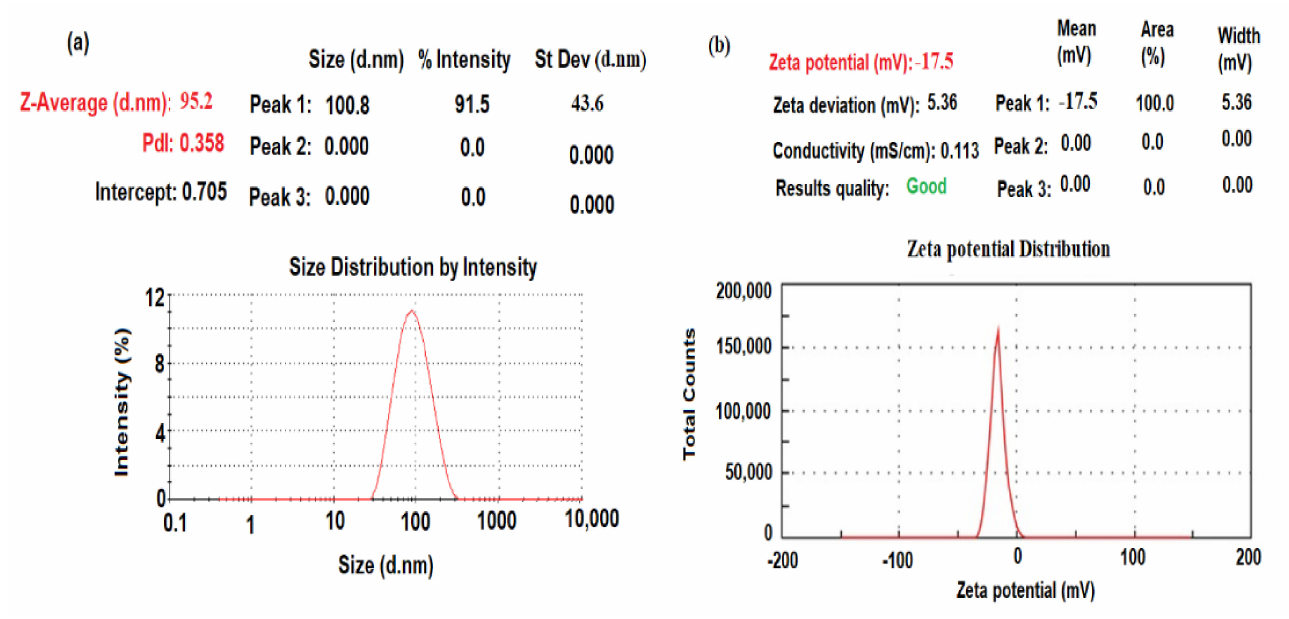
Figure 4. ( a ) DLS and ( b ) zeta potential of biogenic synthesized CeO 2 NPs using maize silk extract. The zeta potential of particles with negative values of about − 17.2 mV indicated